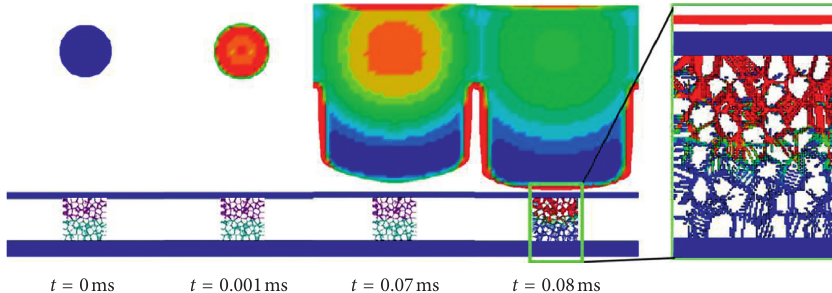
Figure 8: Compressed foam aluminum cover.